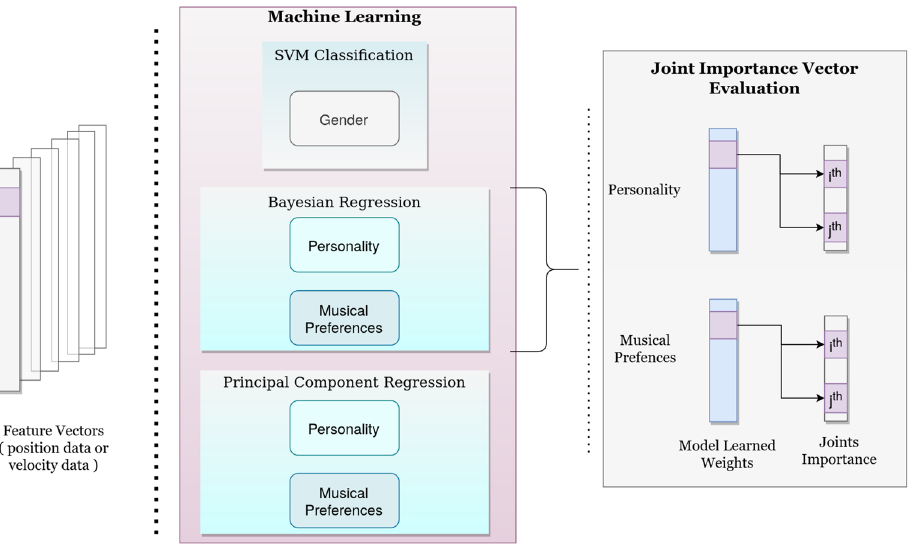
Figure 10. Overview of our ML tasks and Joint importance vector evaluation pipeline. Given the extracted feature vectors, we apply SVM for gender classification, and Bayesian Regression & PCR for predicting personality and musical preferences. Then, using the trained regression model, we evaluate trait-wise Joint Importance vectors